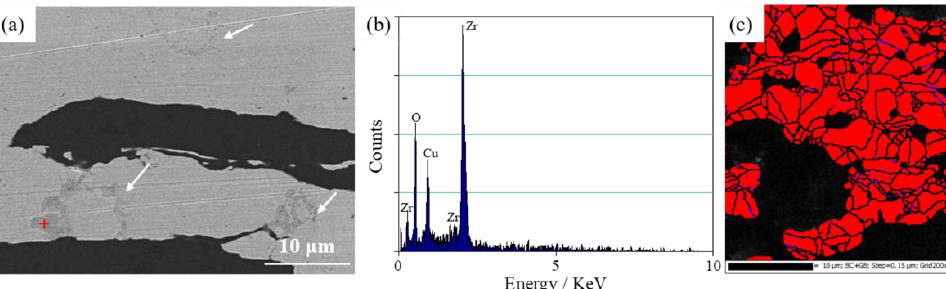
Figure 7. ( a ) SEM image indicating Zr circles in the Cu matrix by white arrows; ( b ) EDS spectrum corresponding to red cross in ( a ); ( c ) EBSD result of FG/Cu composite with 2 wt % Zr. Blue spots represent residual carbon in ( c ).